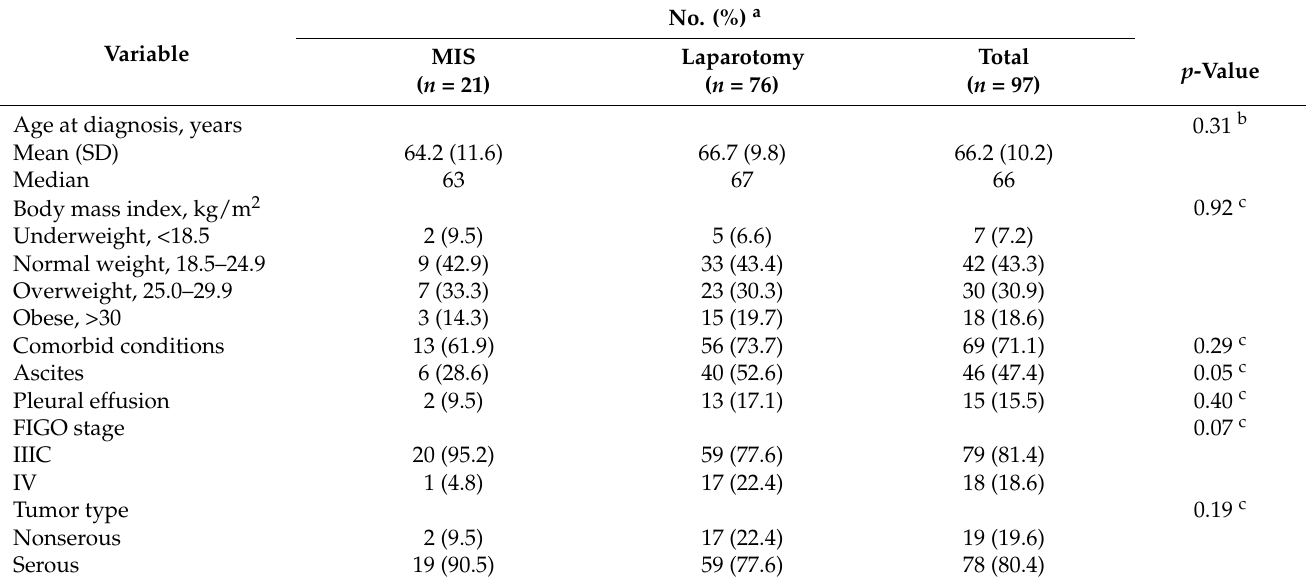
FIGO, International Federation of Gynecology and Obstetrics. a Unless otherwise indicated. b Wilcoxon rank sum test. c χ 2 test. Table 2. Demographic variables, tumor factors, and FIGO stages for the interval debulking group.